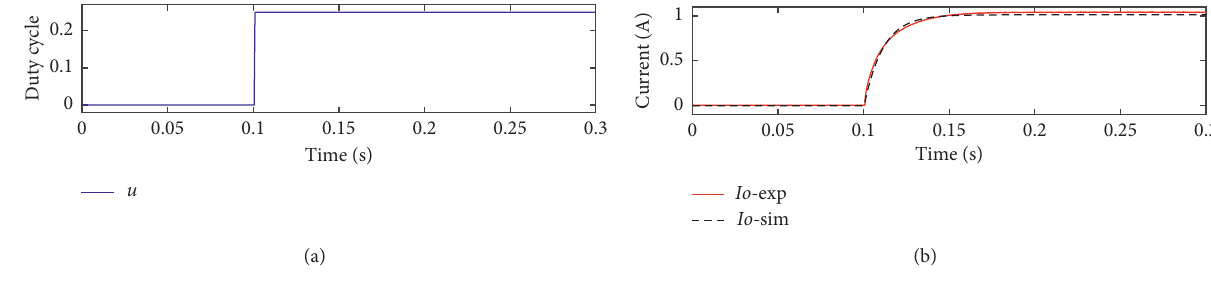
Figure 2: The step response of the uncontrolled system. Table 1: Parameters of MR damper coil (25 ° C). Parameters